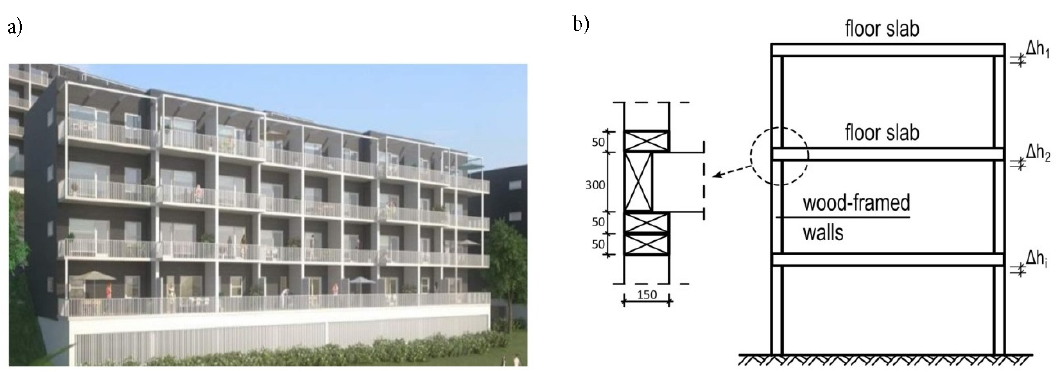
Figure 2. Multistorey large panel building: a – constructed building; b – assembly phase of wooden building